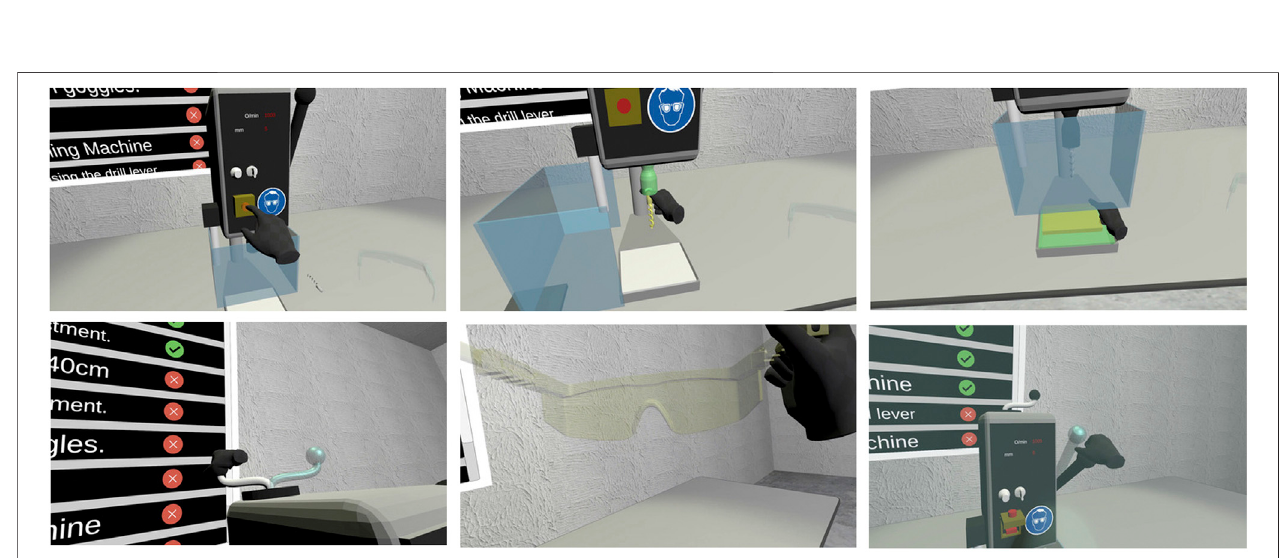
FIGURE 9 | Some of the steps followed in the tutorial execution mode alongside with the animation and highlight indications.